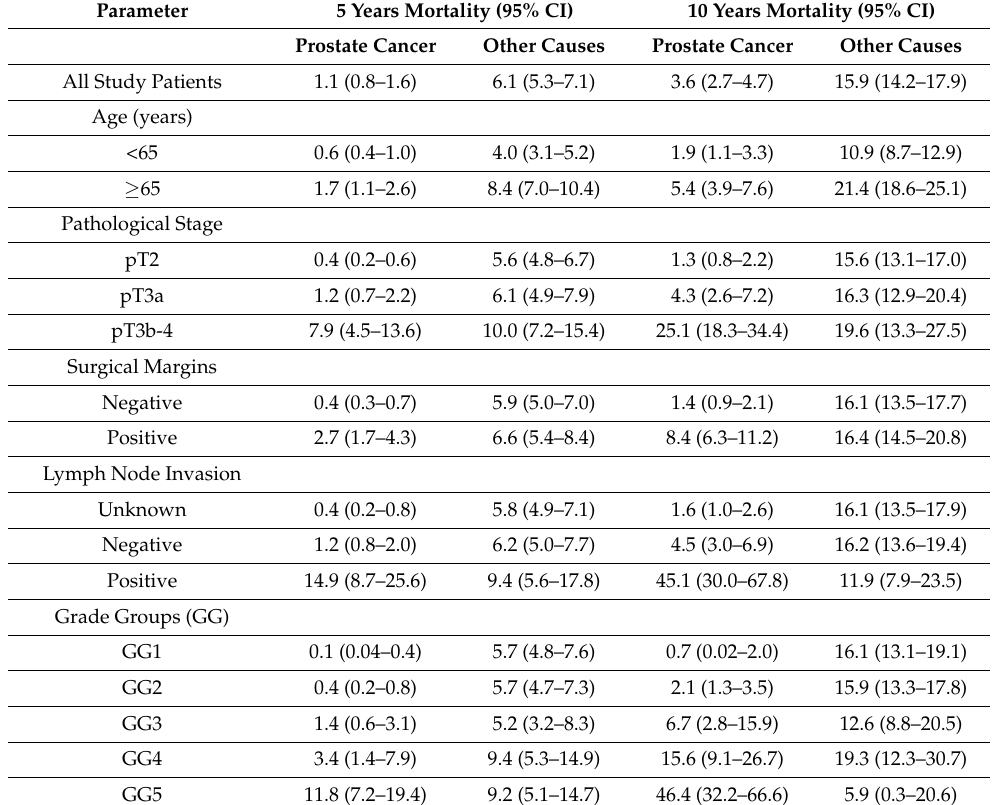
Table 2. Cumulative 5- and 10-year mortality from cancer and other causes according to age, patho- logical stage, surgical margin status, lymph node status, and grade